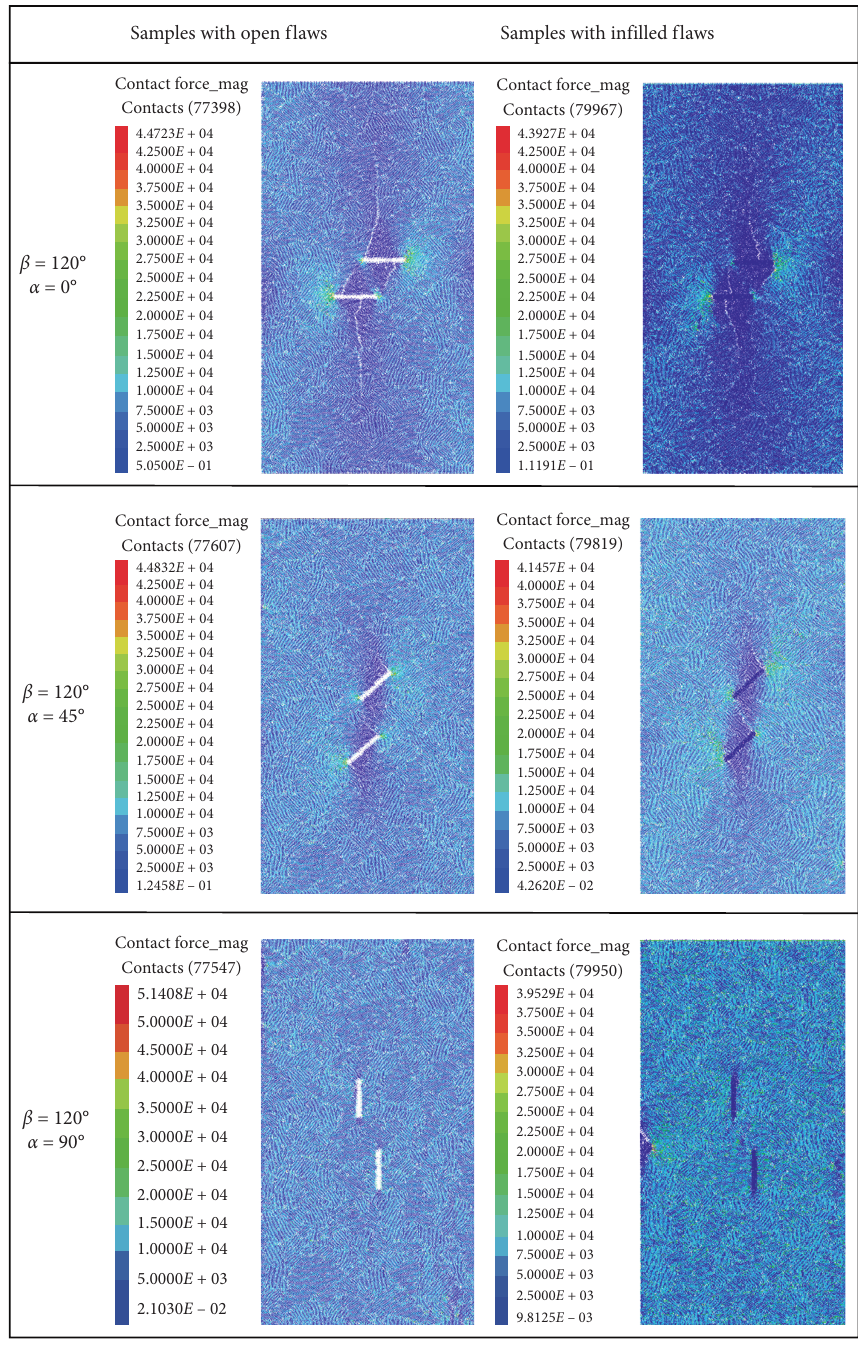
Figure 14: Contact force of samples containing open and infilled flaws with β of 120 ° and α of 0 ° , 45 ° , and 90 ° when the loading stress reaches the peak